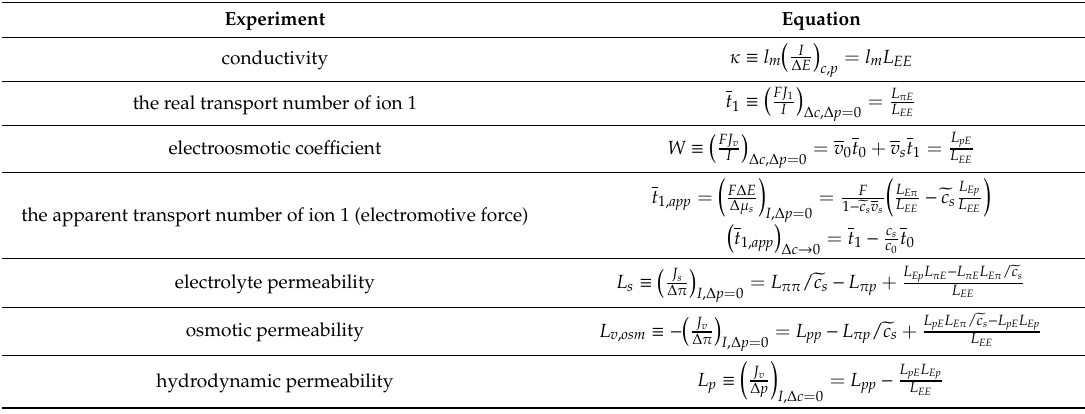
Table 1. List of experiments, equation for 1:1